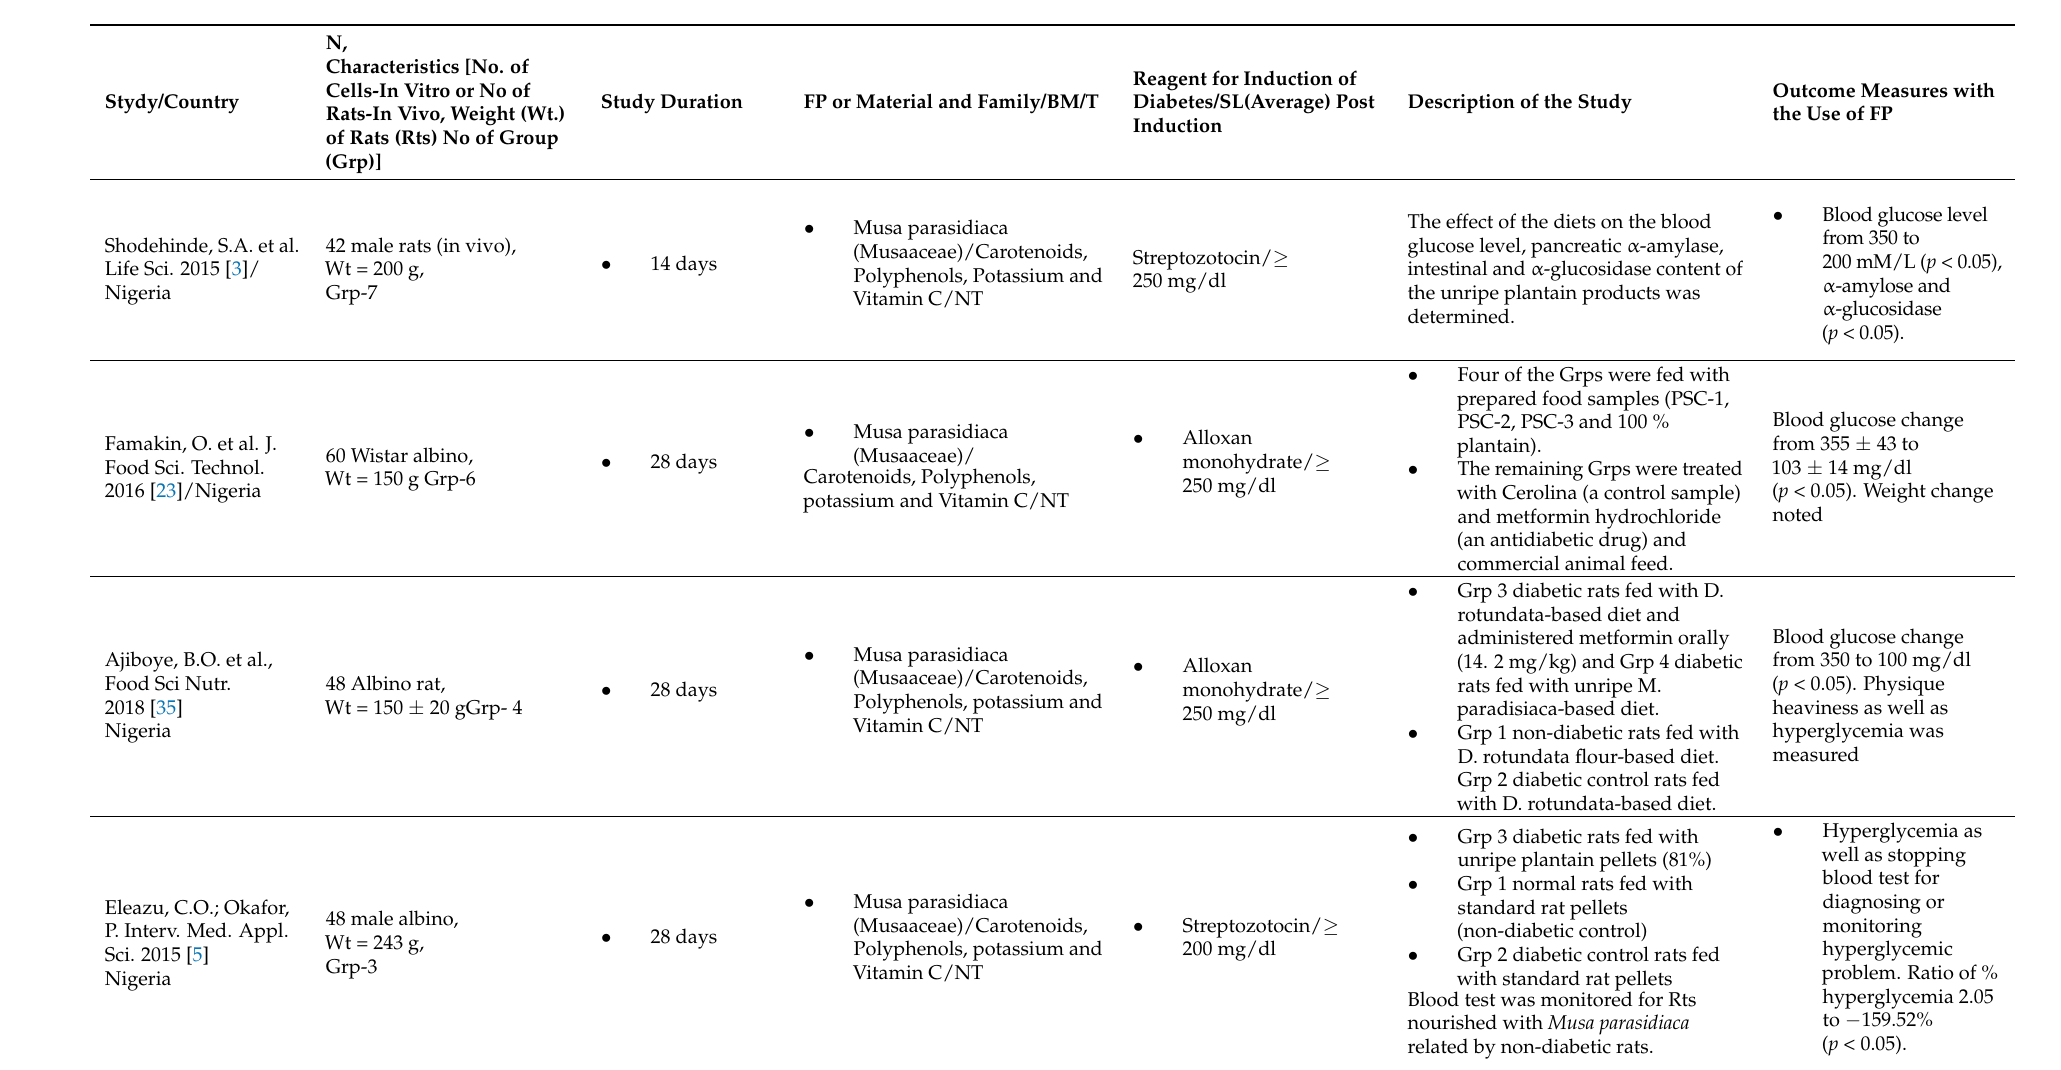
Table 6. General characteristics of included studies Baseline characteristics of rats or cell